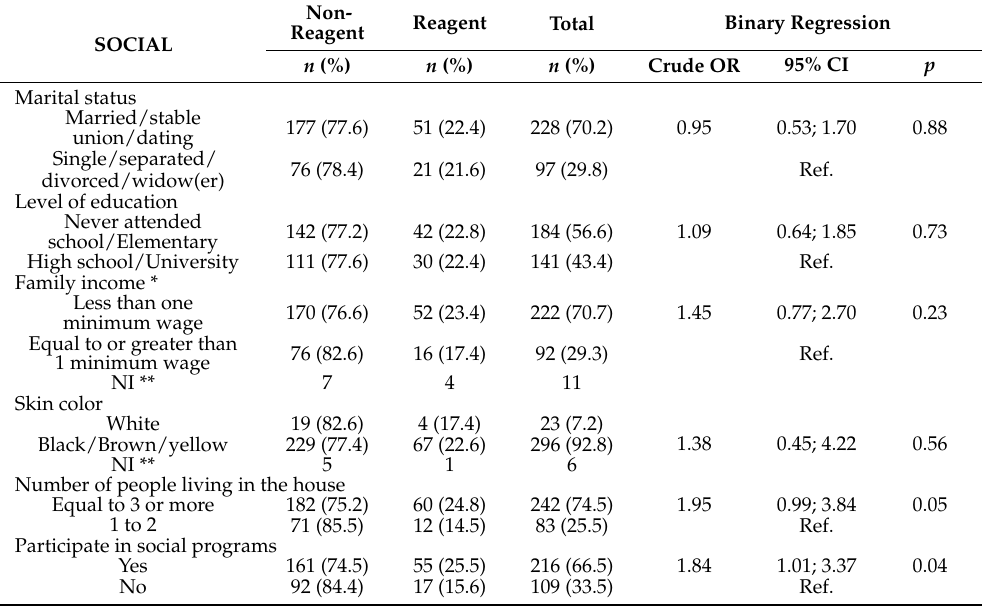
Table 1. Social factors associated with serology for C. trachomatis among riverine, in the